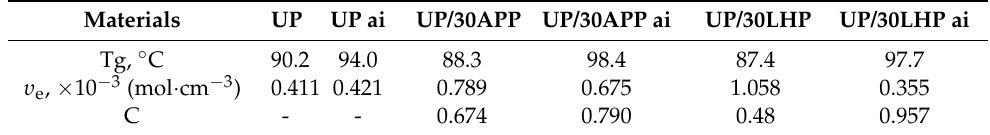
Figure 5. DMA results of unmodified and modified with APP and LHP before and after immersion in water (ai). Table 2. Structural and thermomechanical properties of unmodified and modified UP before and after water immersion obtained by